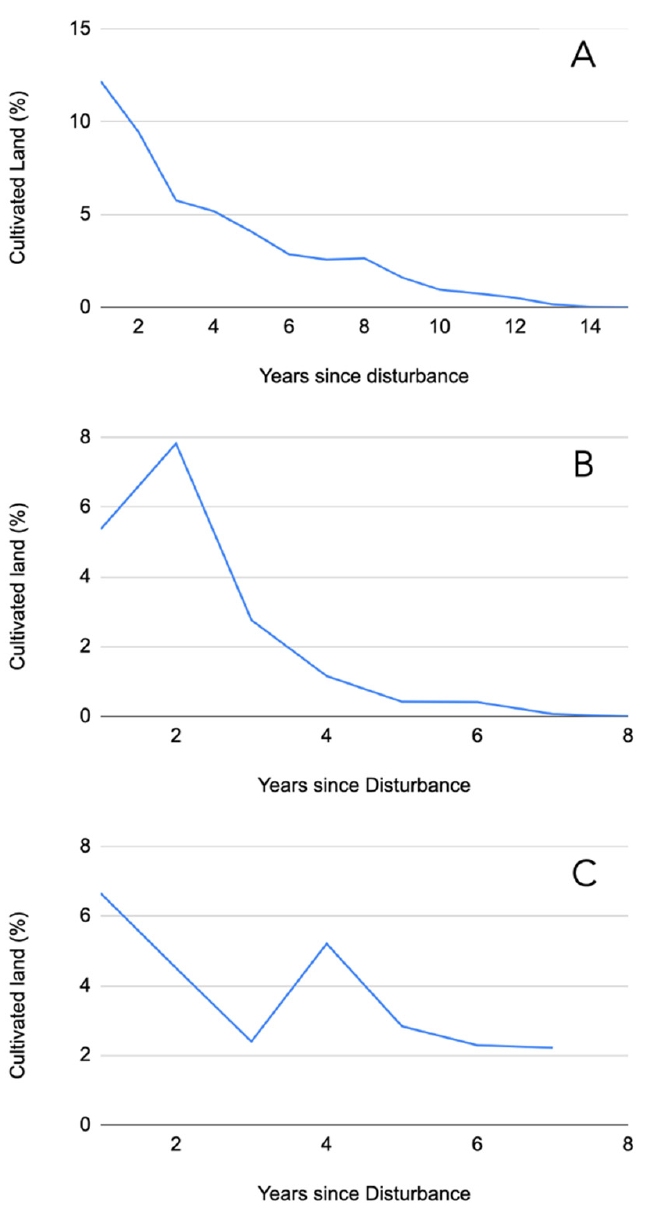
Figure 11. Number of years between charcoal production and cultivation (percentage of cultivated land from degraded land). ( A ) Kapiri Mposhi; ( B ) Katarino; ( C )